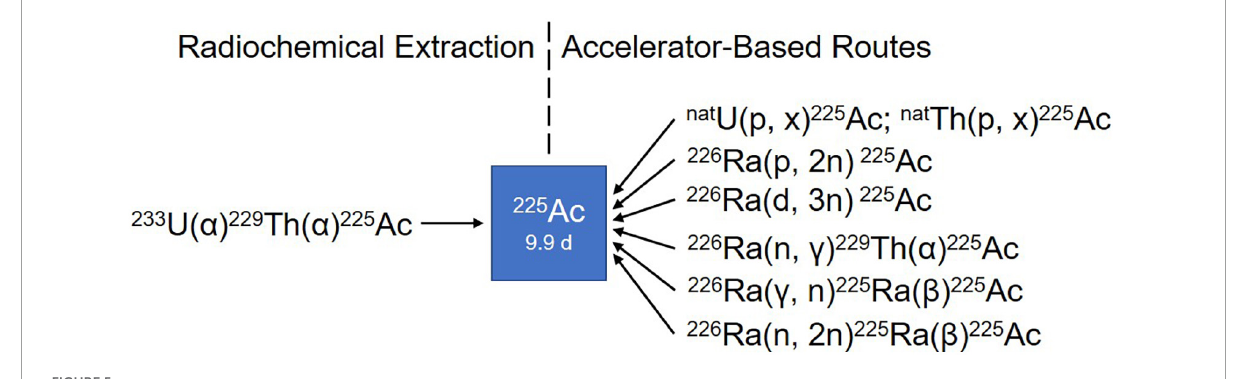
FIGURE5 Production routes of 225